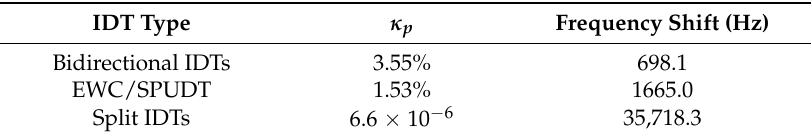
Table 2. Reflectivity and frequency shift of the three different